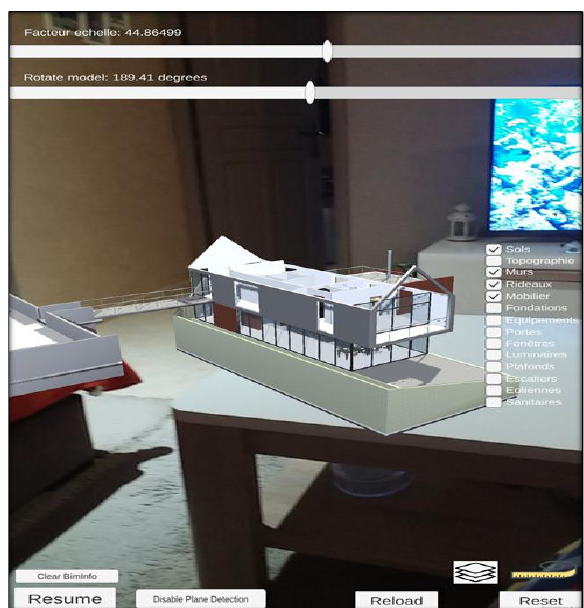
Figure 3. Visualization of BIM information related to each “BIM